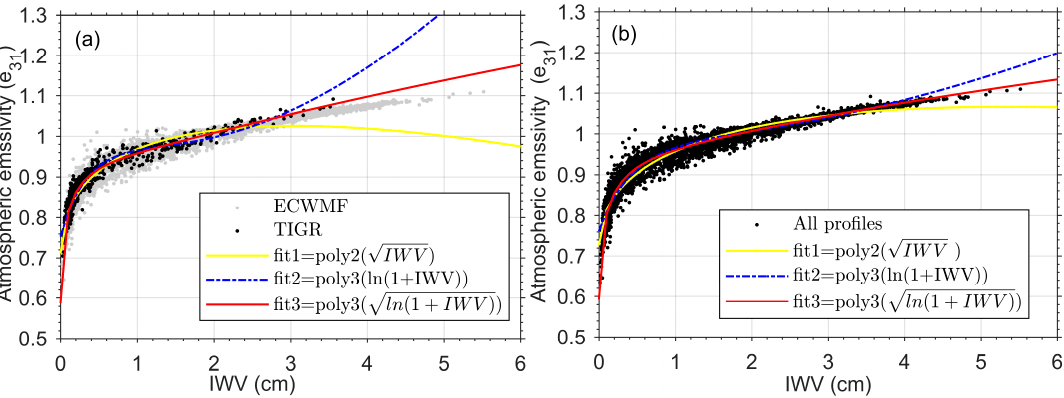
Figure 4. Atmospheric emissivity ( ε 31 ) defined by Equation (3) using brightness temperature (BT) of MODIS 31st channel, plotted as functions of IWV at the condition of conifer surface, H = 1.435 km, view zenith angle (VZA) = 0 ◦ , and δ T s,a = 0 K. The black and gray dots represent TIGR2002 and ECWMF profiles, respectively. Only the TIGR2002 profiles were used in regression in Figure ( a ), and all the TIGR2002 and the ECWMF profiles were used in Figure ( b ). Poly2 and poly3 represent quadratic and cubic function, respectively.